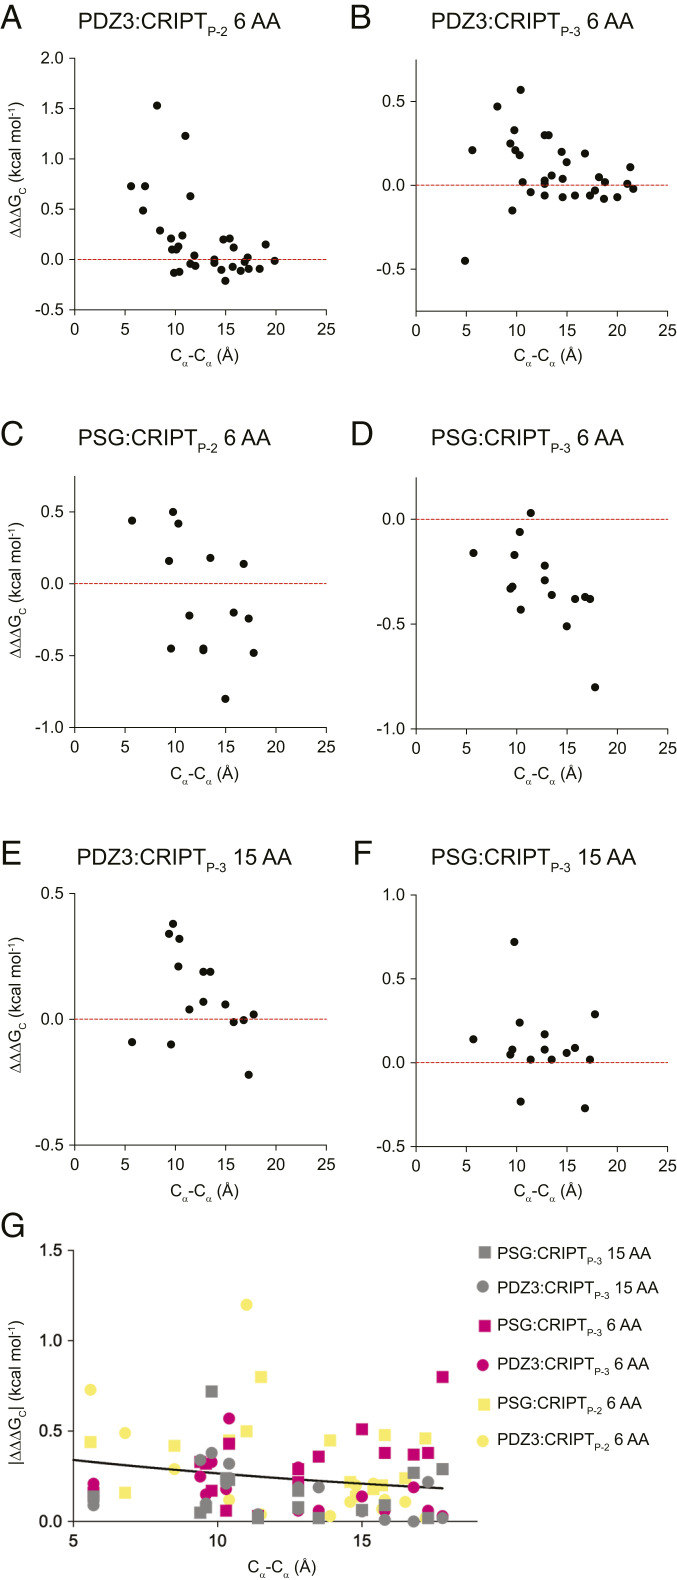
Distance dependence of coupling free energies between CRIPT and PDZ3 or PSG. The coupling free energies were plotted versus CαCα distance between the mutated residues in PDZ3 and CRIPT, respectively, for the six different allosteric networks: (A) PDZ3:CRIPTP-2 6 AA, (B) PDZ3:CRIPTP-3 6 AA, (C) PSG:CRIPTP-2 6 AA, (D) PSG:CRIPTP-3 6 AA, (E) PDZ3:CRIPTP-3 15 AA, and (F) PSG:CRIPTP-3 15 AA. The red horizontal line divides negative from positive coupling free energies. (G) The absolute number of all coupling free energies |∆∆∆Gc| from our double-mutant cycles in PDZ3 and PSG show no significant distance dependence, as illustrated by the exponential fit (distance constant dc = 21 ± 11 Å).